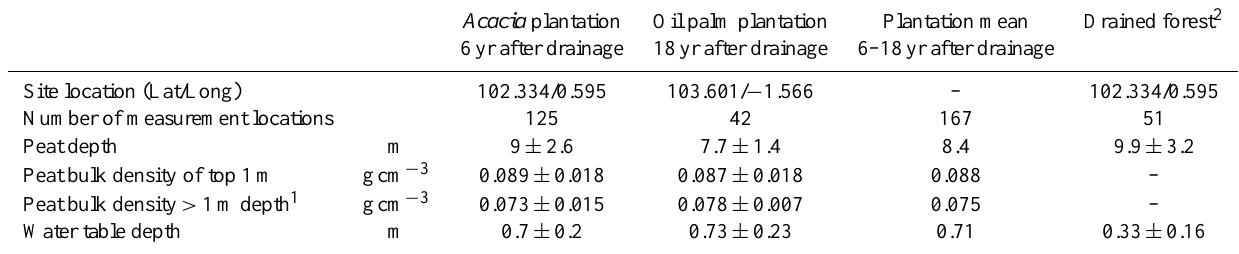
Table 1. Summary of measurement site characteristics. Averages are provided with standard deviations.